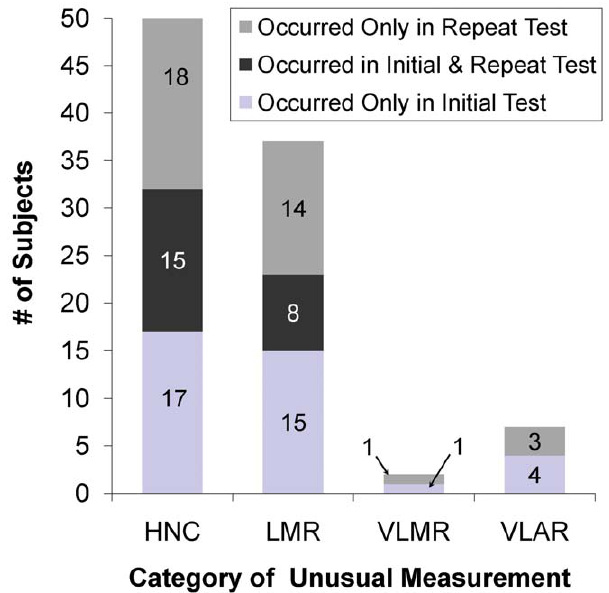
Figure 4. Number of subjects with unusual IFN- c measure- ments when QuantiFERON-TB Gold and QuantiFERON-TB Gold In-Tube tests were run simultaneously. The number of subjects with unusual IFN- c measurements categorized as High Nil Concentra- tion ( HNC ), Low Mitogen Response ( LMR ), Very Low Mitogen Response ( VLMR ), and Very Low Antigen Response ( VLAR ) that occurred only with the QuantiFERON-TB Gold test (light gray bars), with the QuantiFERON-TB Gold In-Tube test (dark gray bars), or in both the QuantiFERON-TB Gold and QuantiFERON-TB Gold In-Tube test (medium gray bars) among 1,617 subjects with simultaneously performed QuantiFERON-TB Gold and QuantiFERON-TB Gold In-Tube Test.